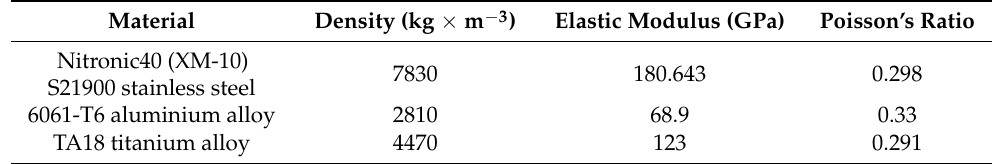
Table 4. Pipeline material parameters.